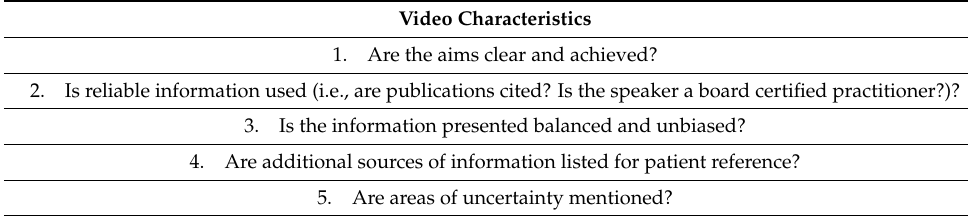
Table 2. Modified DISCERN (MD).